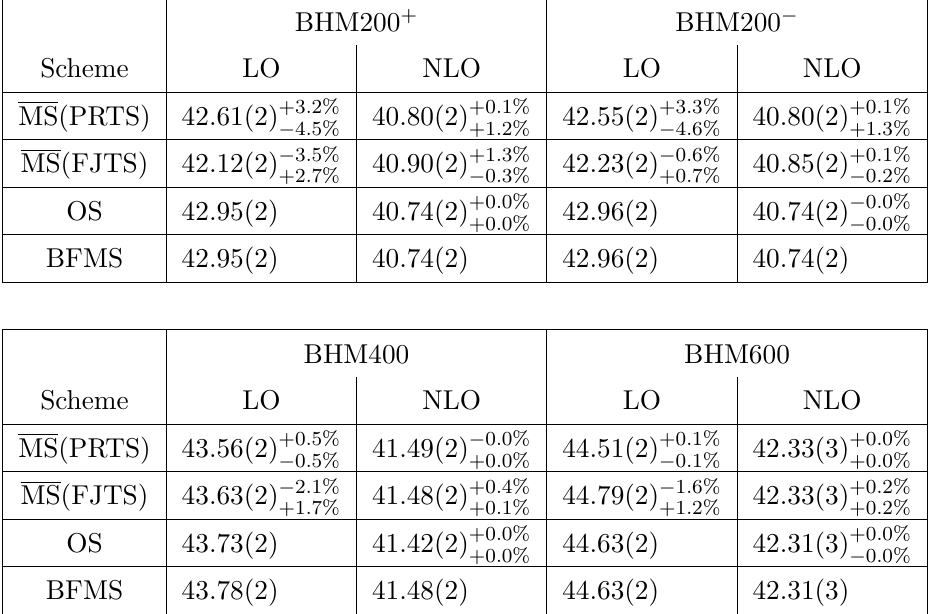
Table 9 . LO and NLO integrated cross sections (cid:27) [pb] for the production of the light Higgs boson in Higgs-strahlung, pp H 2 (cid:22) + (cid:23) (cid:22) + X , for various HSESM scenarios in di(cid:11)erent renormalization ! schemes, with the OS scheme as input scheme (and full conversion of the input parameters into the other schemes). The scale variation (given in percent) corresponds to the scales (cid:22) = (cid:22) 0 = 2 and (cid:22) = 2 (cid:22) 0 with central scale (cid:22) 0 = M H . 2 invariant mass M j > 130 1 j 2 (cid:15)